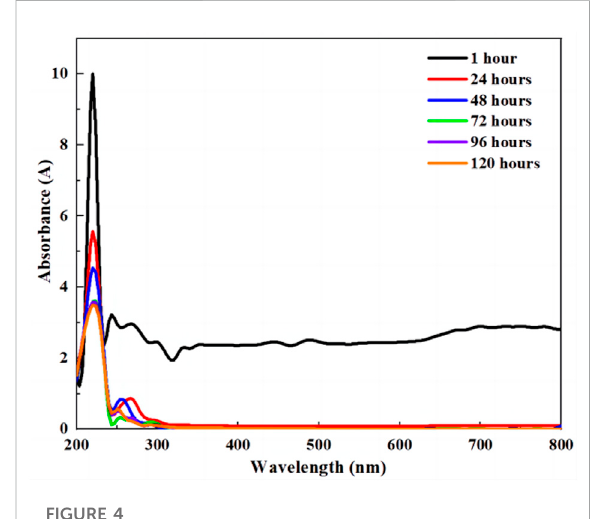
Absorbance of nano-LiBr without E414.